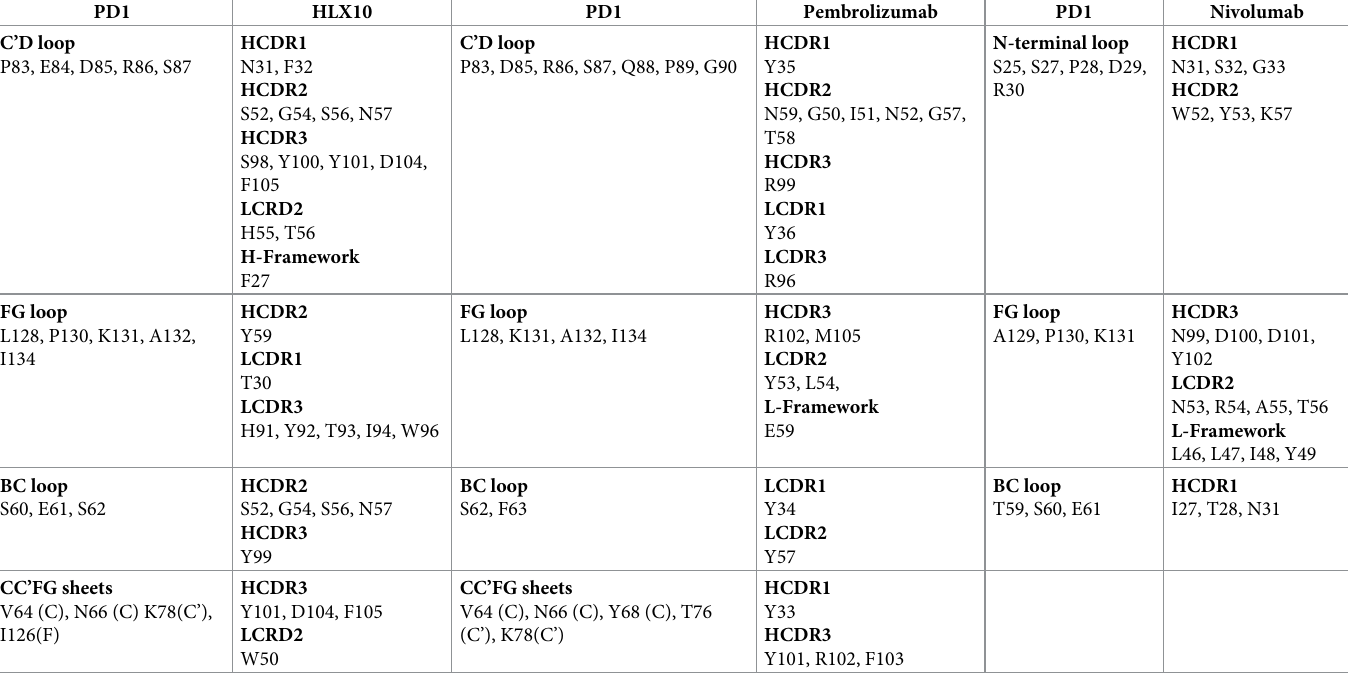
Table 3. Comparison of Paratope and Epitope of HLX10, Pembrolizumab and Nivolumab.